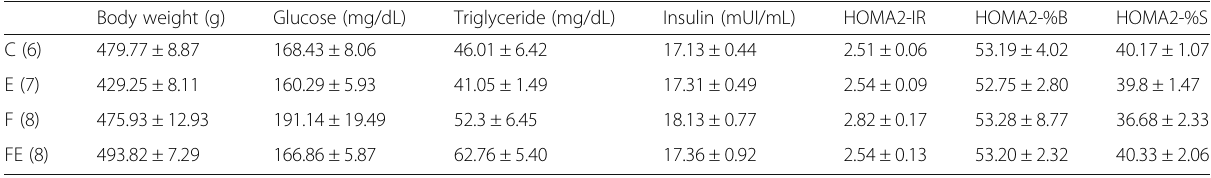
Table 2 Body weight and metabolic profile after week 8 of fructose ingestion or treadmill training Body weight (g) Glucose